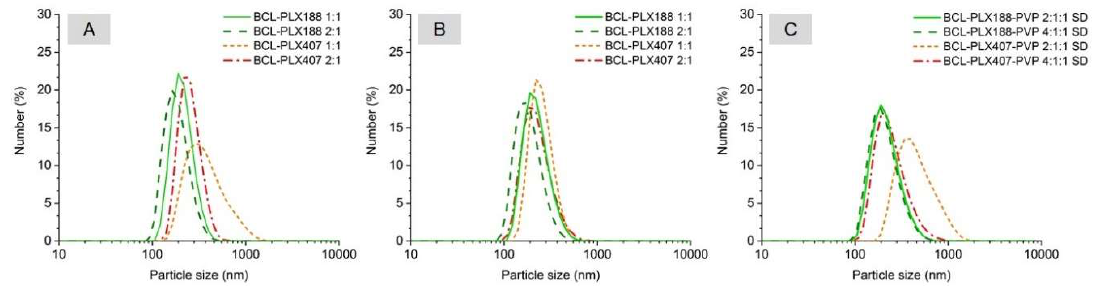
Figure 11. Number-weighted particle size distribution of aqueous solutions of evaporated ( A ), spray-dried binary ( B ), and ternary ( C ) solid dispersions.